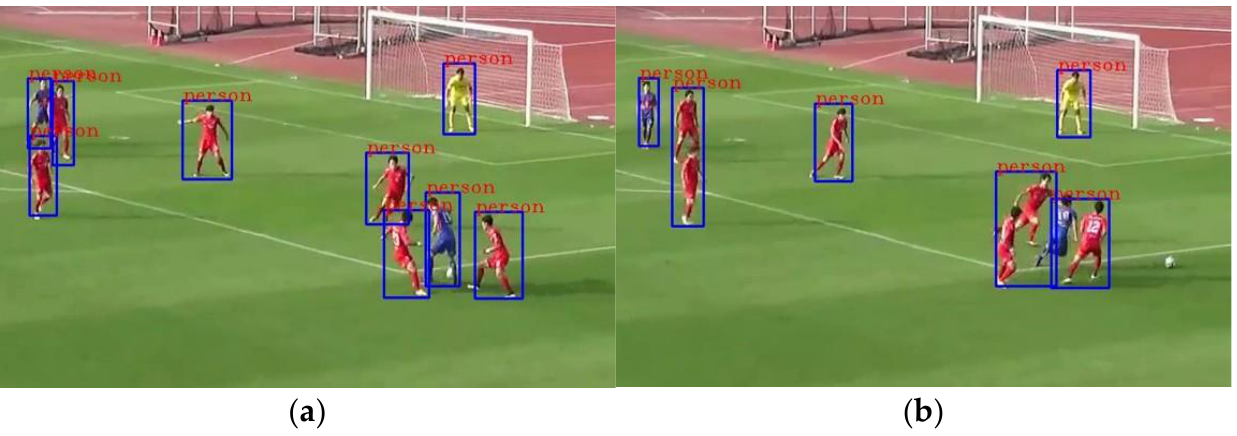
Figure 2. Examples of object classification according to recognition range: ( a ) person recognition of one object; ( b ) person recognition of overlapped areas.